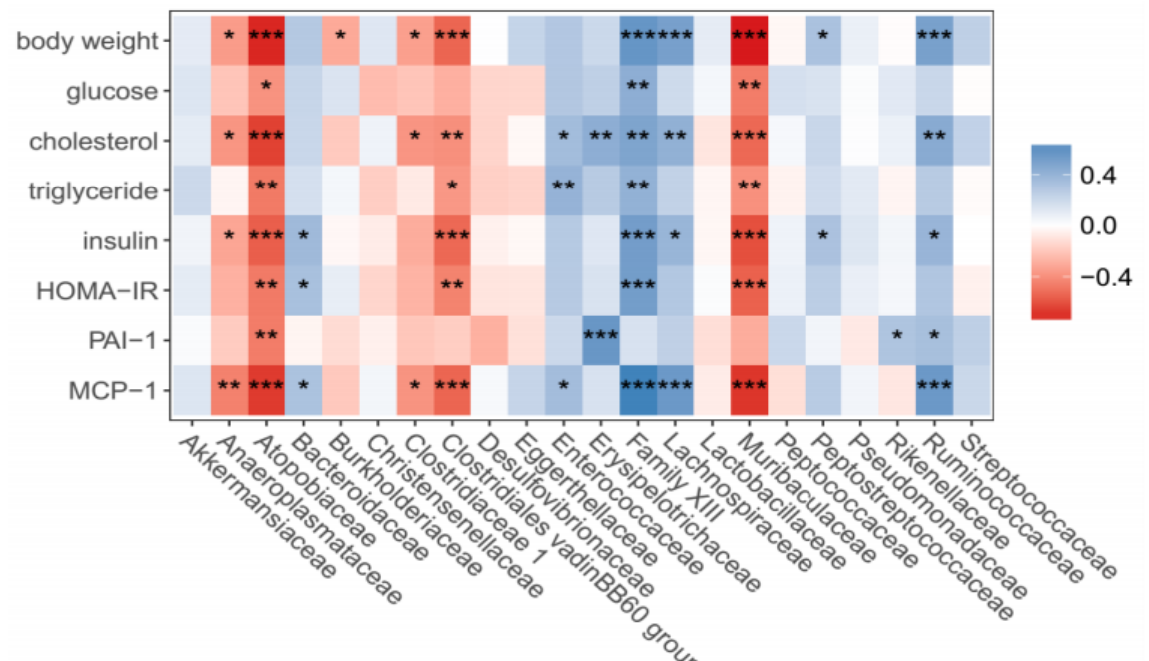
Figure 8. Correlation heat map of relative abundance of gut microbiota, at the family level, with physiological and biochemical parameters. The experimental regimen is described in the legend of Figure 4. *, **, ***: p < 0.05 or 0.01 or 0.001 in positive (blue) or negative (red) correlations between the abundance of each gut family bacteria and physiological or biochemical variables in the mice ( n = 40).